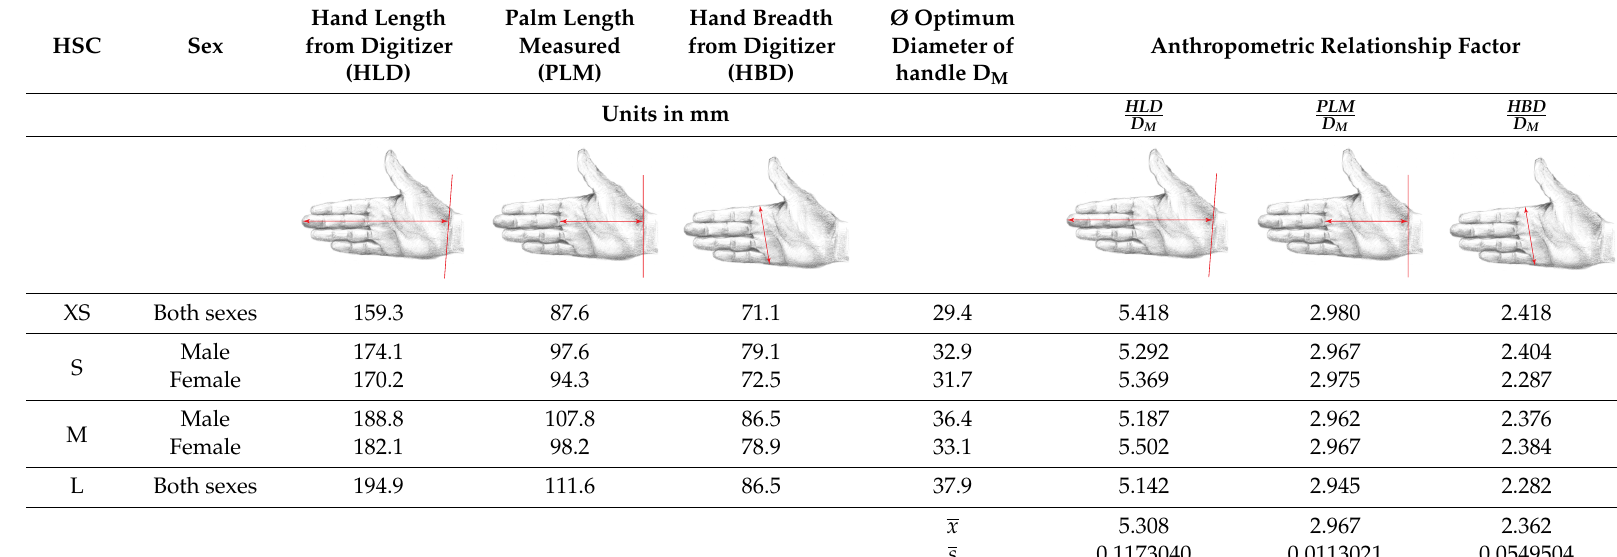
Table 4. Relationships between the Hand Length from Digitizer (HLD), Palm Length Measured (PLM), and Hand Breadth from Digitizer (HBD) dimensions and the optimal median diameters of a laparoscopic surgery handle.